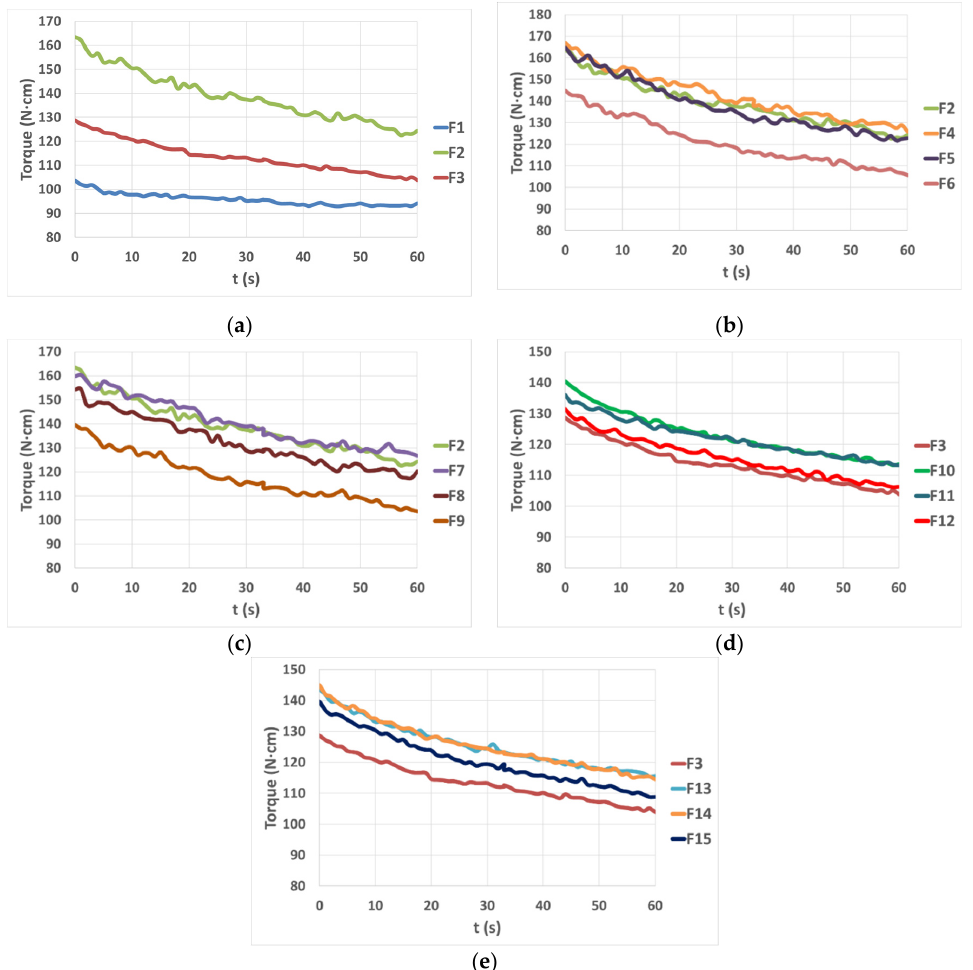
Figure 2. Torque values of: ( a ) pure matrix (F1) and untreated HSP (F2, F3); ( b ) H0210 (F2) and ESO+MA at different concentrations (F4, F5, F6); ( c ) H0210 (F2) and ESO/SA at different concentrations (F7, F8, F9); ( d ) HM200 (F3) and ESO+MA at different concentrations (F10, F11, F12); ( e ) HM200 (F3) and ESO/SA at different concentrations (F13, F14, F15). Table 3. Difference of torque values between the beginning (T 0 ) and the end (T f ) of the extrusion process for all the prepared samples. Higher torque differences represent a faster decay of torque over time.